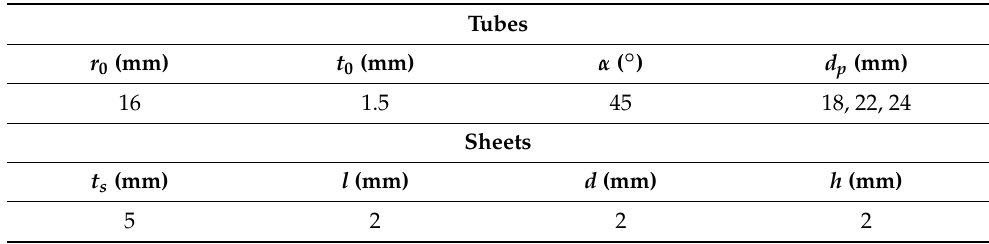
Table 1. Main parameters for the tubes and sheet flange at different stages of the joining process as depicted in Figure 1.